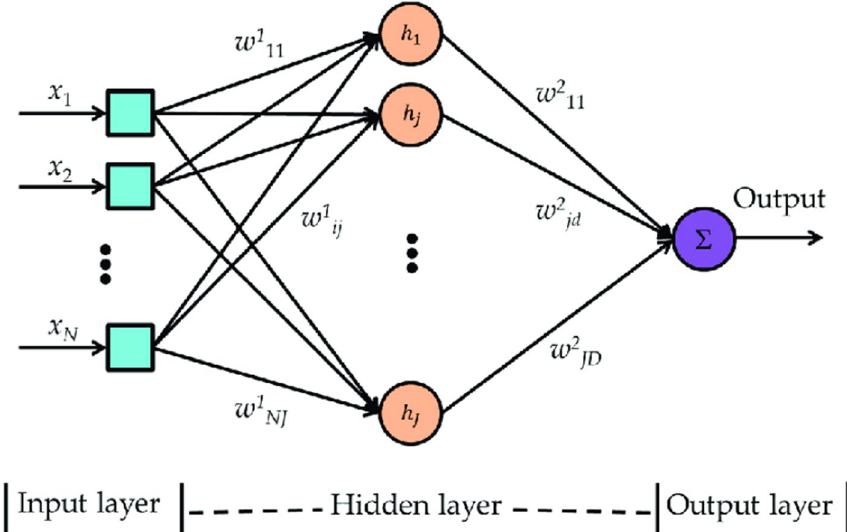
Figure 8. Basic structure of the MLP Neural Networks (NNs).